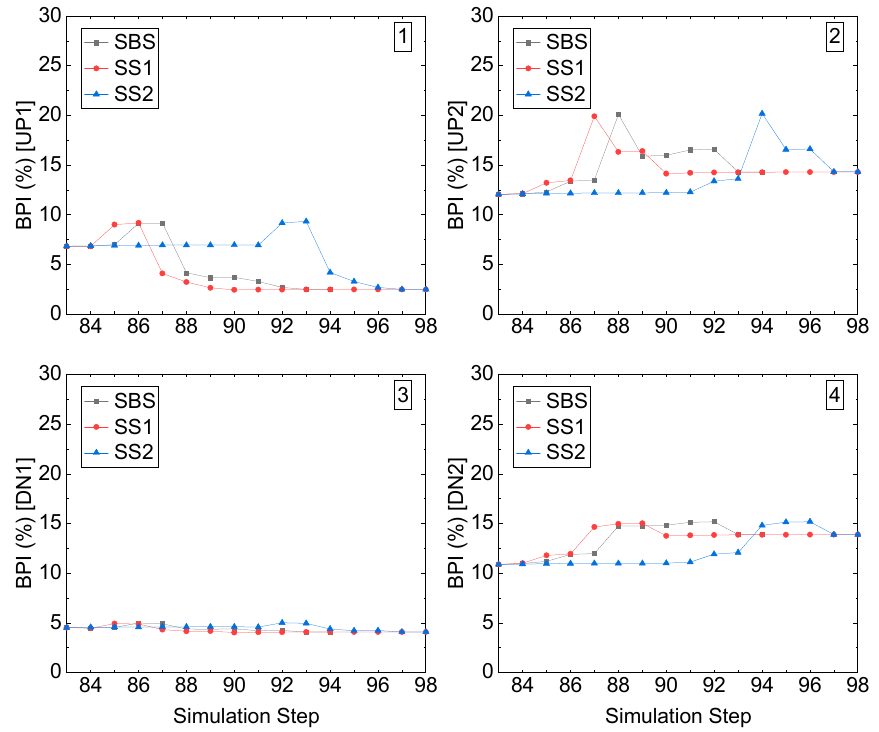
Figure 17. BPI value of the right-edge stope access to the undercut in Sill-1.